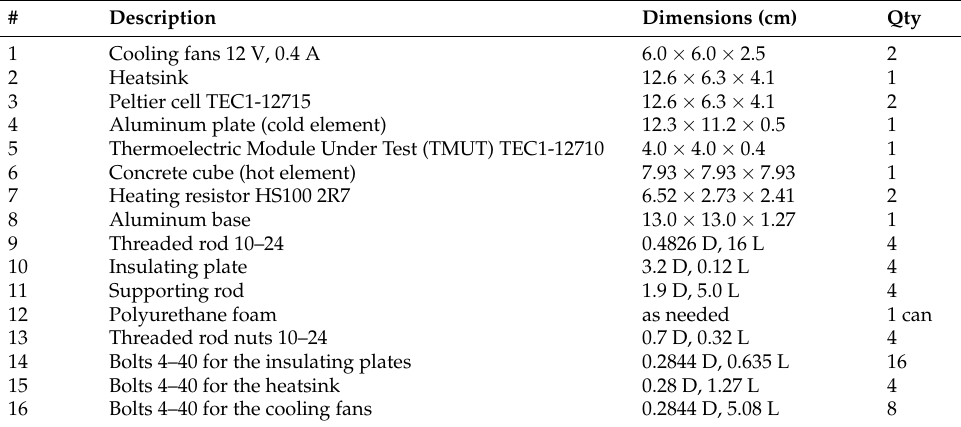
Table 1. List of mechanical components. Description, dimensions, and quantity of the materials that were used for the construction of the prototype. Elements 1 to 11 are the same ones as those in Figure